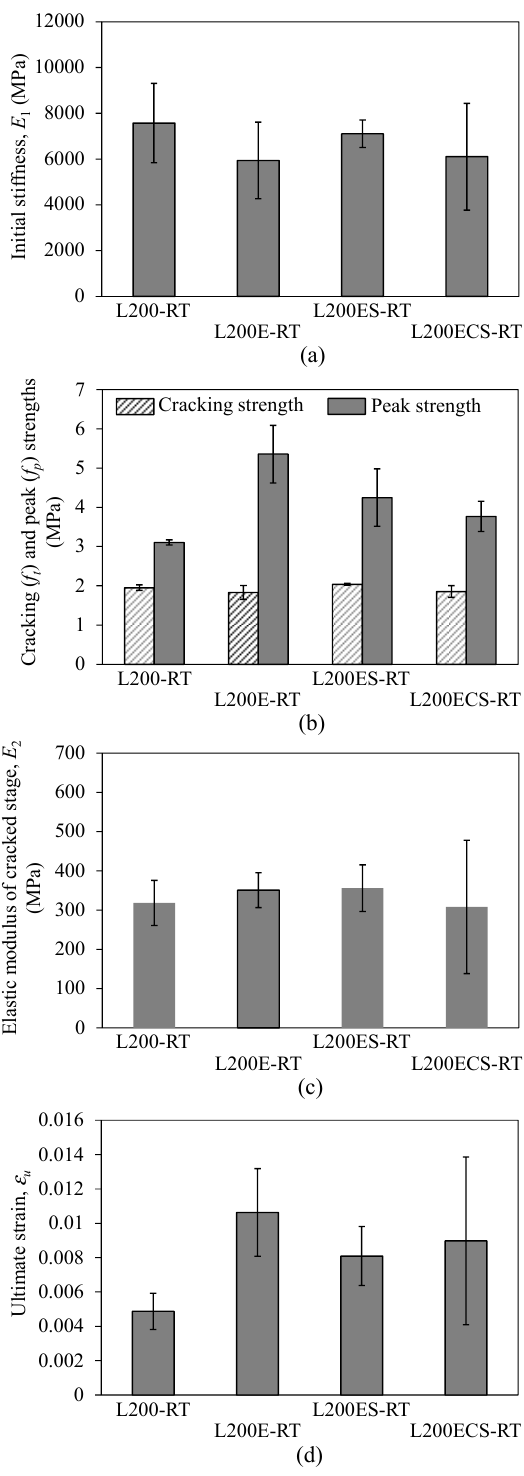
Figure 15. E ff ect of the details in lap splice area on ( a ) initial sti ff ness, ( b ) cracking and peak strengths, Figure 15. Effect of the details in lap splice area on ( a ) initial stiffness, ( b ) cracking and peak strengths, ( c ) elastic modulus of cracked stage, and ( d ) ultimate strain of TRM ( c ) elastic modulus of cracked stage, and ( d ) ultimate strain of TRM specimens.